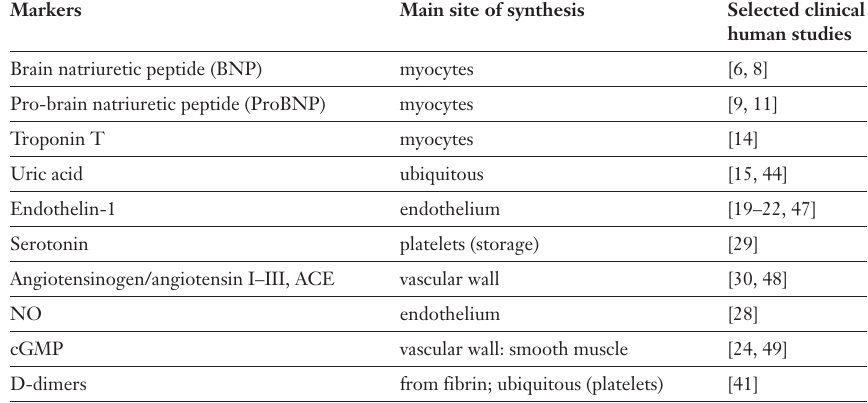
Potential biochemical markers in pulmo- nary